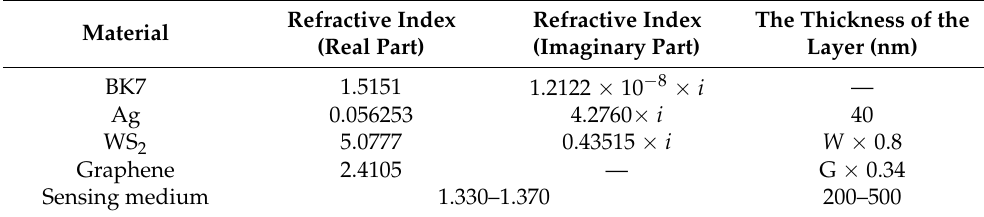
Figure 1. Proposed model of symmetrical surface plasmons resonance sensor. Table 1. Geometrical and physical parameters of the SPR sensor at 632.8 nm.